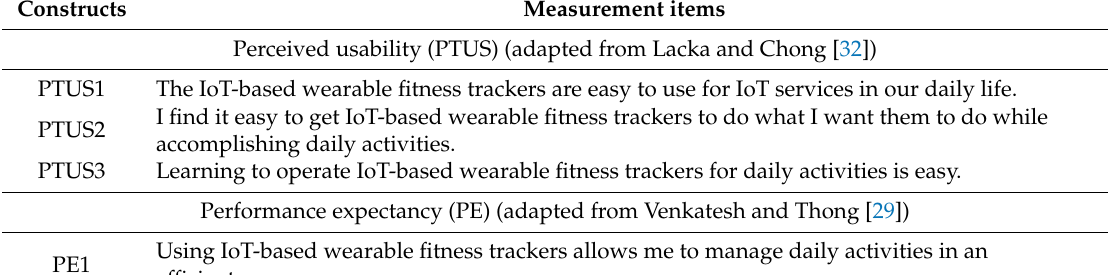
Table A2. Questionnaire